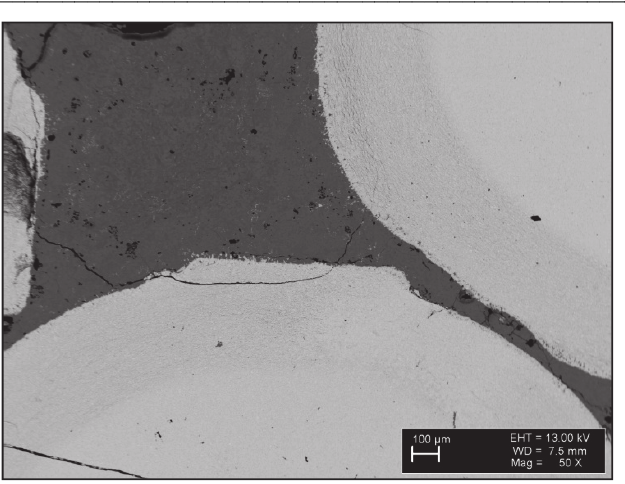
Fig. 3. Enhanced, experimental sample from the laboratory of Tallinn University of Technology, showing the microstructure of the studied hardfacings. Composite hardfacing with 50 vol. % spherical WC-Co reinforcement. The numerical hardface data that were implemented in (1) and (2) for optimization correspond to this kind of material. The interface is sharply shown in upper right circumference around the interior hardface surface.